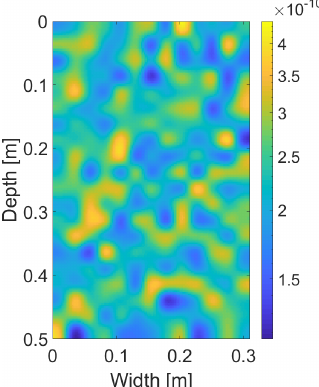
Figure 3. The distribution of the intrinsic permeability κ (m 2 ), which satisfies κ max /κ min ≈ 4. Intrinsic permeability values are color coded according to the color bar on the